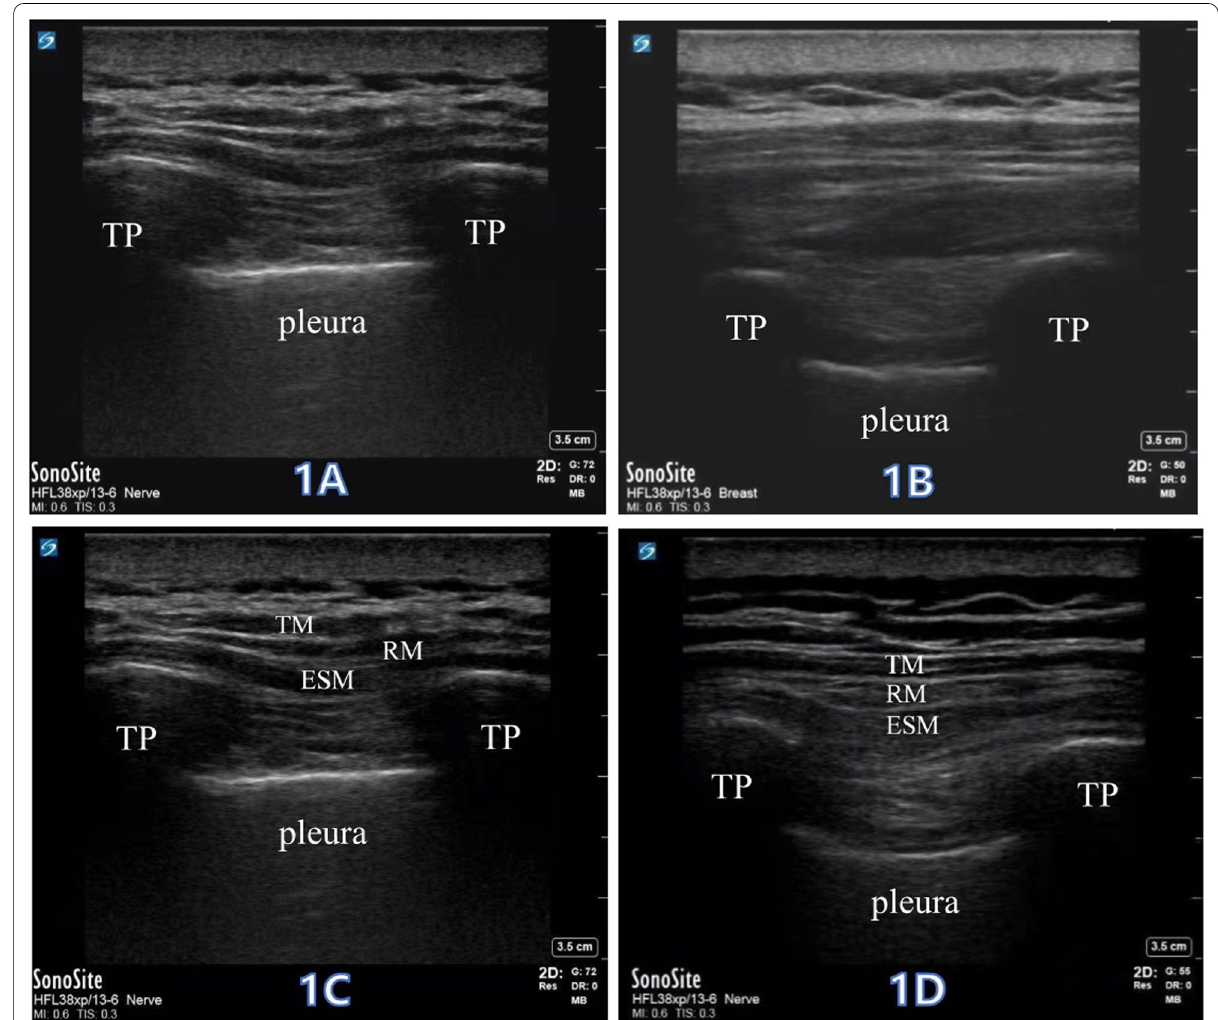
Fig. 1 The ultrasound‑guided thoracic paravertebral nerve block and erector spinae plane block. a , b An ultrasound high‑frequency line array probe was used to scan at approximately 2–2.5 cm next to T4–5 spinous process in the median sagittal position. The transverse process (TP), pleura, and thoracic paravertebral space could be clearly visualized under the ultrasound, and 30 ml of 0.5% ropivacaine hydrochloride was injected into T4–5 paravertebral spaces using an out‑of‑plane approach technique. a Ultrasound‑guided thoracic paravertebral nerve block before injection. b After ultrasound‑guided thoracic paravertebral nerve block by local anesthetic injection, the pleura would be pushed downward. c , d An ultrasound high‑frequency line array probe was used to scan at approximately 2–2.5 cm next to T4–5 spinous process in the median sagittal position. With an out‑of‑plane approach technique, trapezius muscle (TM), rhomboid muscle (RM) and erector spinae muscle (ESM) were sequentially breached, and 30 ml of 0.5% ropivacaine hydrochloride was injected into the deep surface between erector spinae muscle and T4 and T5 transverse processes (TP). c Ultrasound‑guided erector spinae plane block before injection. d Ultrasound‑guided erector spinae plane block after